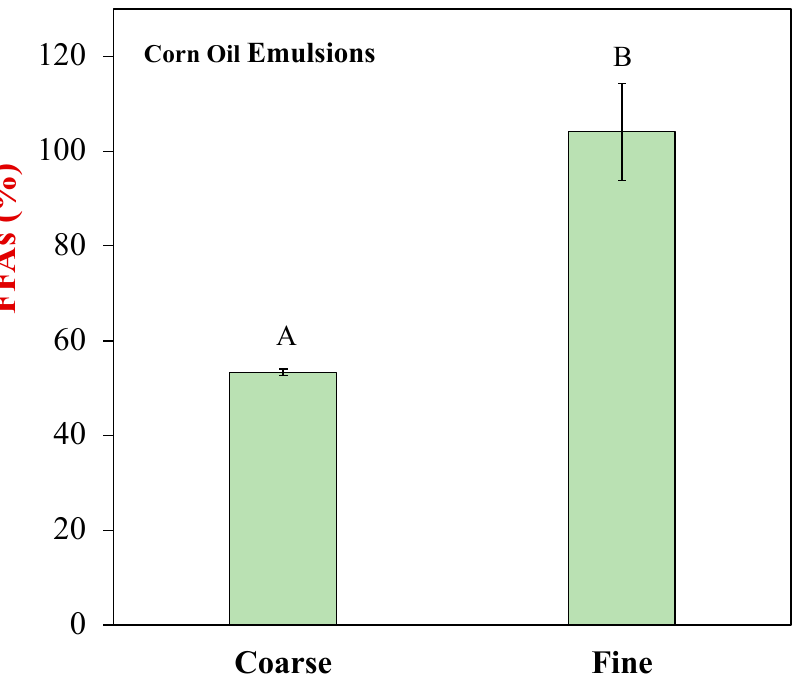
Figure 5. Free fatty acids released at the end point of small intestinal phase of different plant-based egg formulas. Significance difference ( p < 0.05) of samples is labeled with capital letters (A, B).